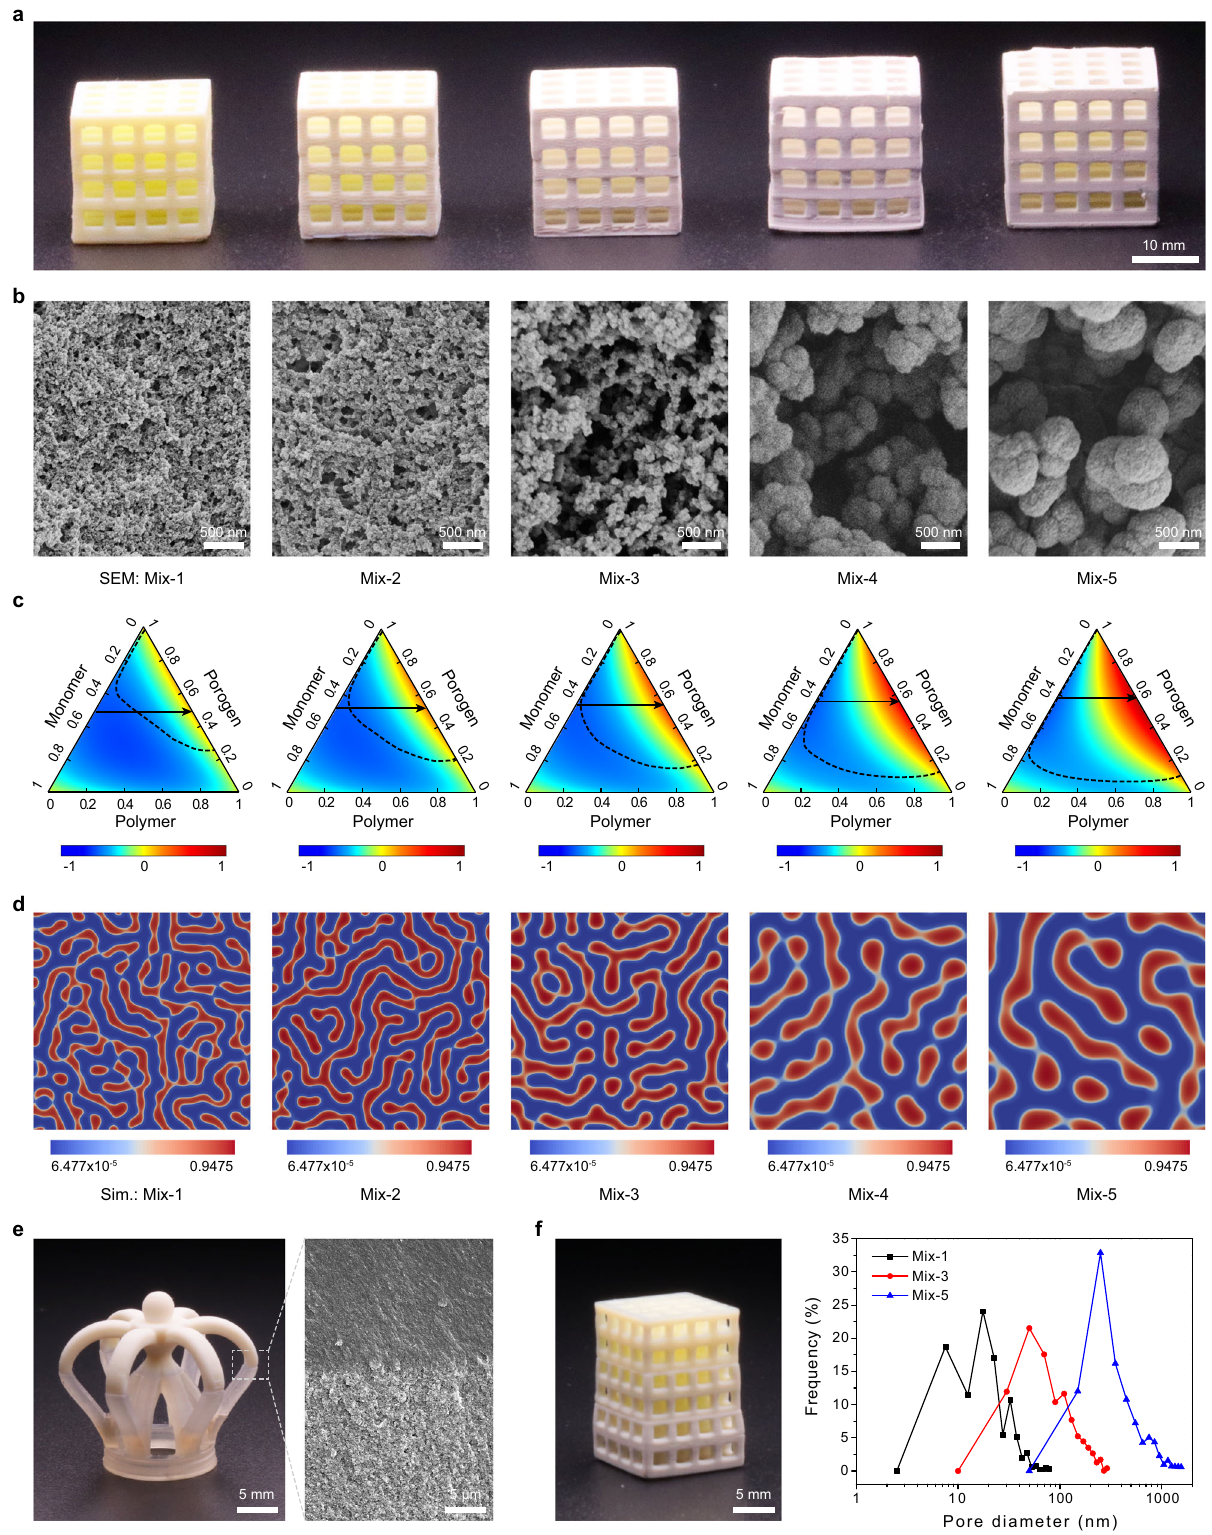
1-decanol concentration, which leads to phase separation at an The evolution of the nanoporous structures leads to a dramatic earlier stage of polymerization (Fig. 3c). Also, the phase separation change of the physical properties of the 3D printed objects. The takes place more rapidly with increasing the concentration of 1- increase of pore size for objects printed from Mix-1 to Mix-5 decanol, leading to the formation of thicker polymer networks leads to a decrease of their BET surface area from 53.5 m 2 g − 1 to 6.1 m 2 g − 1 (Table 1), and a sharp decline of their transparency (Fig. 3d), which agrees well with the experimental results (Fig. 3b). NATURE COMMUNICATIONS| (2021) 12:247